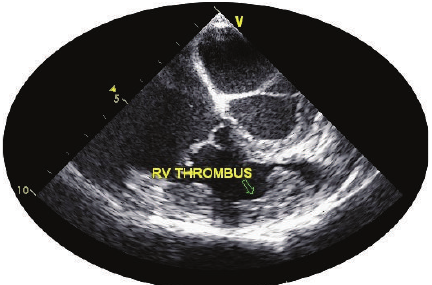
Figure 2: Transoesophageal Echocardiographic (TOE) image at midoesophagus (short axis) showing the right ventricular (RV) thrombus (arrow mark) along the free wall of RV, extending from just below tricuspid valve to the right ventricular outflow beneath the pulmonary